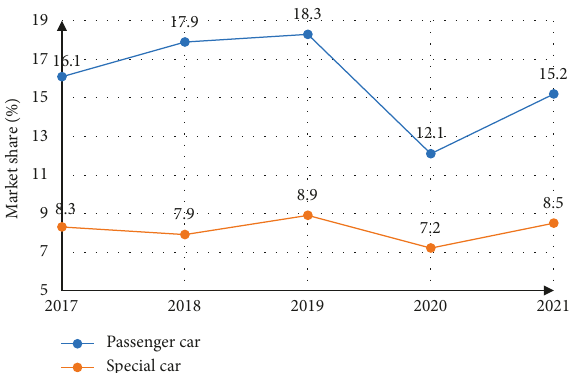
Figure 9: Market shares of company mainly engaged two kinds of cars in nearly five years.